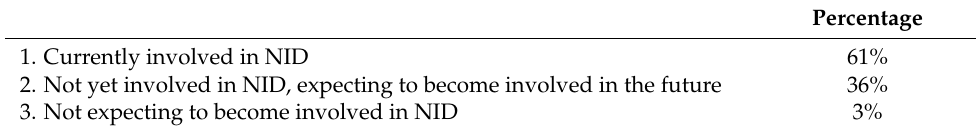
Table 2. Involvement of companies in NID ( n = 88).